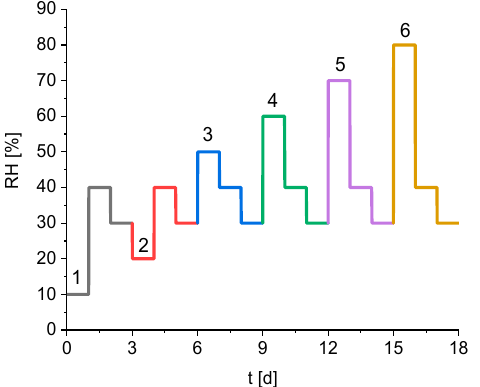
Figure 1. Predetermined humidity profile of the sorption experiment, the numbers mark the six ferent subparts during the different subparts during the experiment.